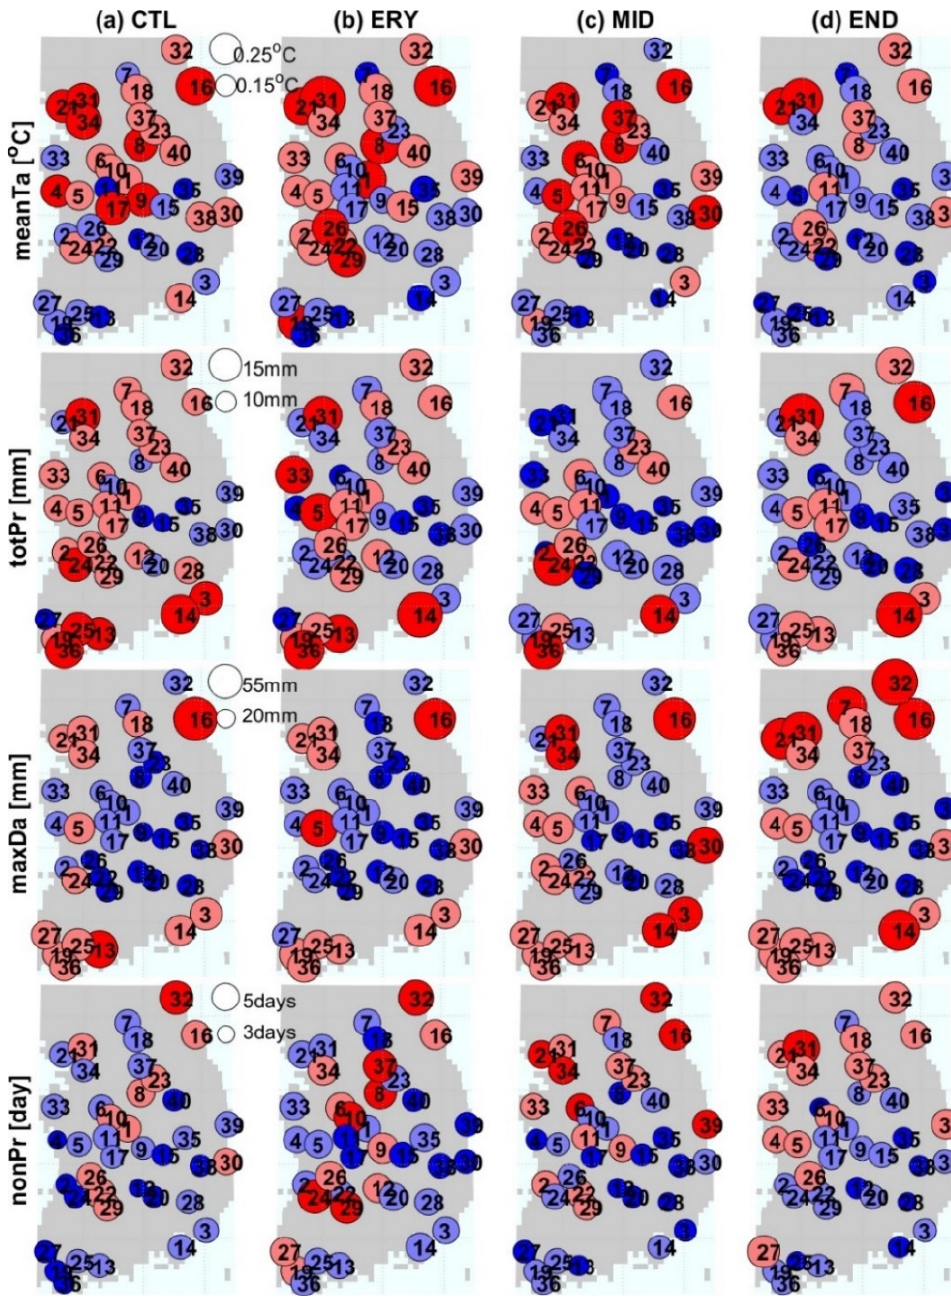
Figure 8. Spatial distribution of the USTO values over South Korea in the ( a ) CTL, ( b ) ERY, ( c ) MID, and ( d ) END periods, with the SSP5-8.5 for 4 indices computed for the whole year. In total, 40 locations are classified into 4 clusters (from the smallest cluster (dark, blue-colored circles) to the largest cluster (red colored circles)) by applying the K-means algorithm.